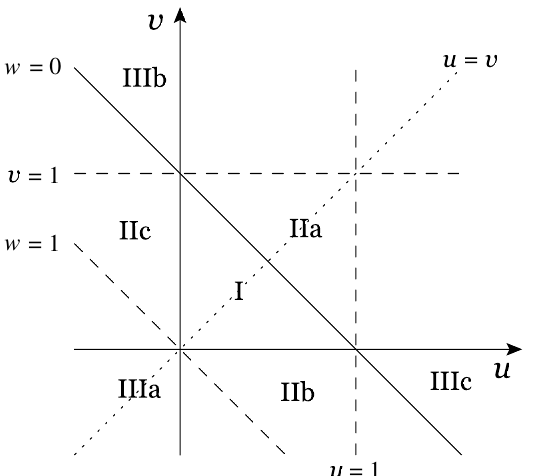
Figure 1. The two-dimensional space of kinematics on which the three-point form factor depends, in the u and v variables. The Euclidean region, where all Mandelstams are negative, is given by the interior of the triangle defined by 0 < u < 1 and 0 < v < 1 − u . The solid edges bounding the Euclidean region correspond to the collinear limits, near which FFOPE data can be accessed. We describe the other physical regions in the